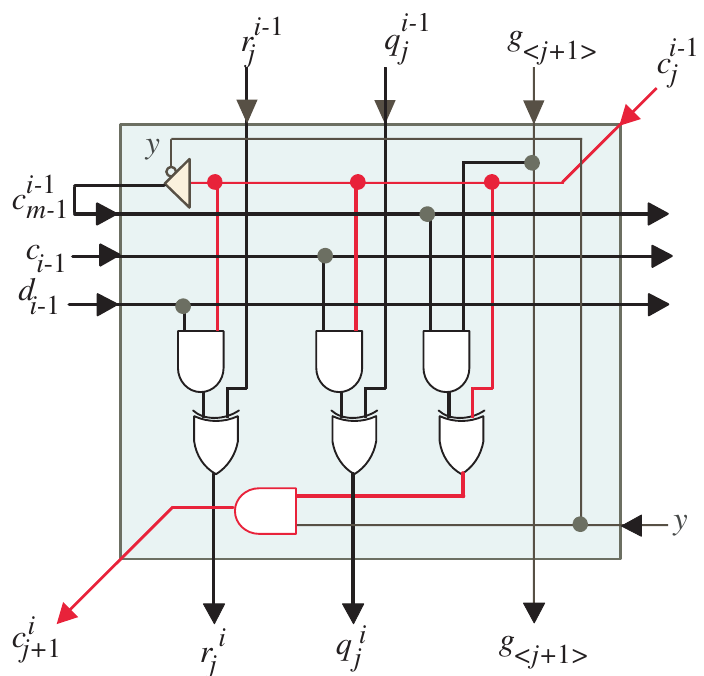
Figure 7. Light blue PE details of SISO two-dimensional systolic array.